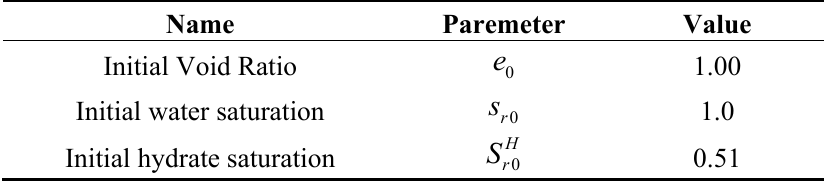
Table 1. Initial conditions of the soil material.